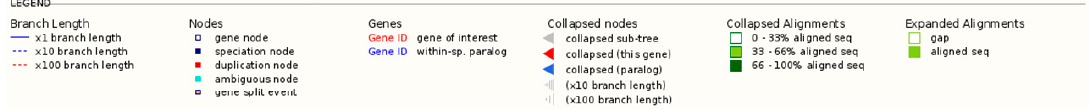
Figure 2. Gene tree for human CYP1A1 , 1A2 , 1B1 , 17A1 , and 21A2 built using Ensembl 84. These five genes are paralogs to each other derived from the same ancestral gene via duplication events. The gene tree includes a total of 537 genes from various species. The total number of speciation nodes is 370, and the number of duplication is 143. The number of ambiguous nodes is 21, and the number of gene split events is 2. Table 1. A list of 57 human functional CYP genes and their corresponding paralogs based on Ensembl 84 and GeneCards 4.1.1.